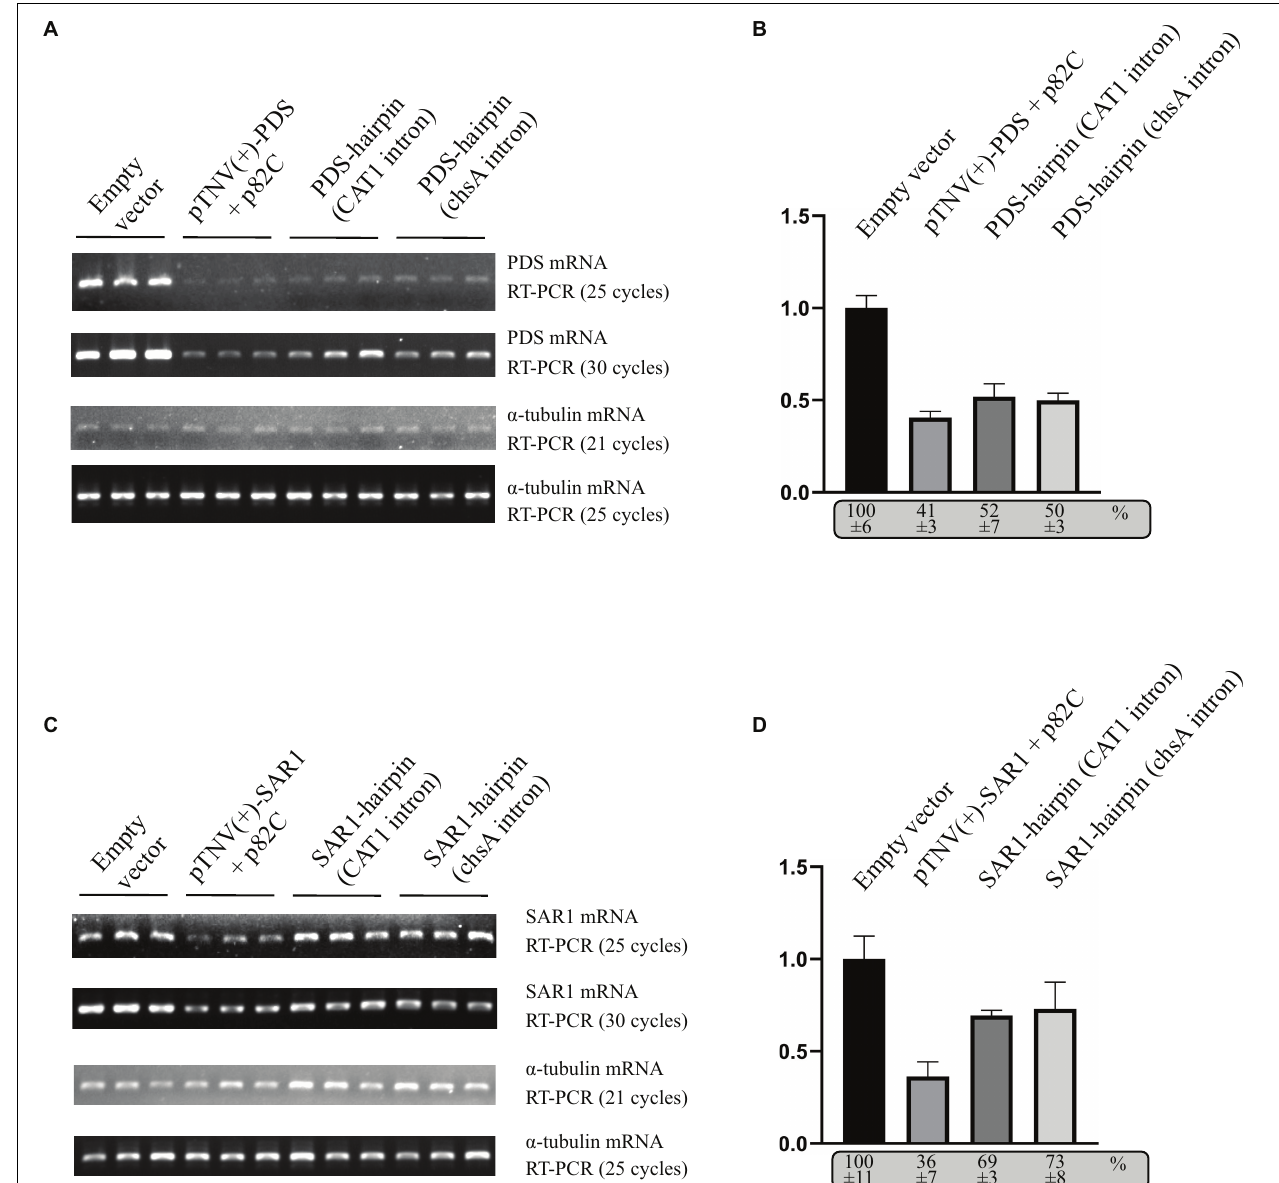
FIGURE 3 | Comparison of the VRAS- and ihpRNA-mediated silencing of PDS or SAR1 genes in N. benthamiana . (A) Semiquantitative PCR was performed to measure the mRNA levels for PDS or α -tubulin coding genes from leaves agroinfiltrated with empty vector [pCB301-314-pTNV(+)-RZ] (OD 600 of 1.0), VRAS vectors [pCB301-314-pTNV(+)-NbPDS-Rz and pGD-2 × 35S-L-TNV-p82C] (OD 600 of 0.5, each), ihpRNA expression vector pGD-35S-CAT1-NbPDS-hairpin (OD 600 of 1.0), or ihpRNA expression vector pGD-35S-chsA-NbPDS-hairpin (OD 600 of 1.0) at 3 dpi. PCR products were analyzed by agarose gel electrophoresis. The number of PCR cycles is shown. (B) qPCR measuring PDS mRNA accumulation. The PDS mRNA level from empty vector-infiltrated leaf samples was set as 100%. Standard error was calculated from three independent repeats. See more details in panel (A) . (C) Semiquantitative PCR was performed to measure the mRNA levels for PDS or α -tubulin coding gene from leaves agroinfiltrated with empty vector [pCB301-314-pTNV(+)-RZ], VRAS vectors [pCB301-314-pTNV(+)-NbSAR1-Rz and pGD-2 × 35S-L-TNV-p82C], ihpRNA expression vector (pGD-35S-CAT1-NbSAR1-hairpin), or ihpRNA expression vector (pGD-35S-chsA-NbSAR1-hairpin) at 3 dpi. PCR products were analyzed by agarose gel electrophoresis. The number of PCR cycles is shown. (D) qPCR measuring SAR1 mRNA accumulation. See more details in panel (B)